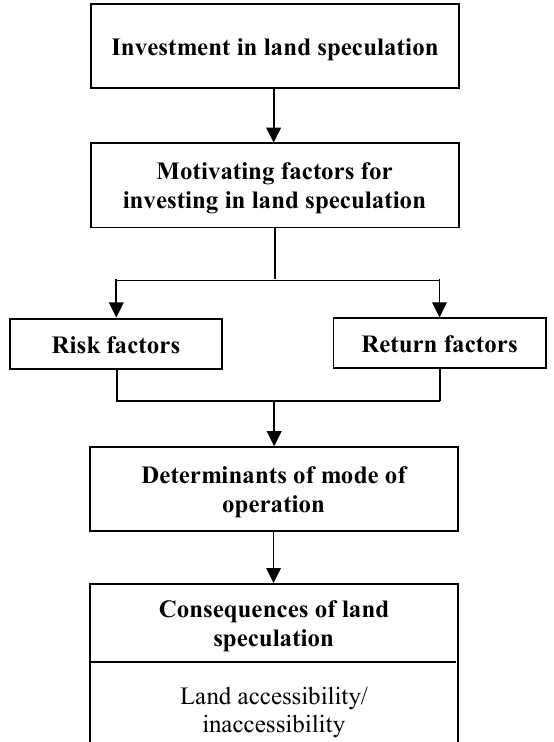
Fig. 1. Eclectic framework depicting decision making of a land speculator to invest in land speculation (compiled by the